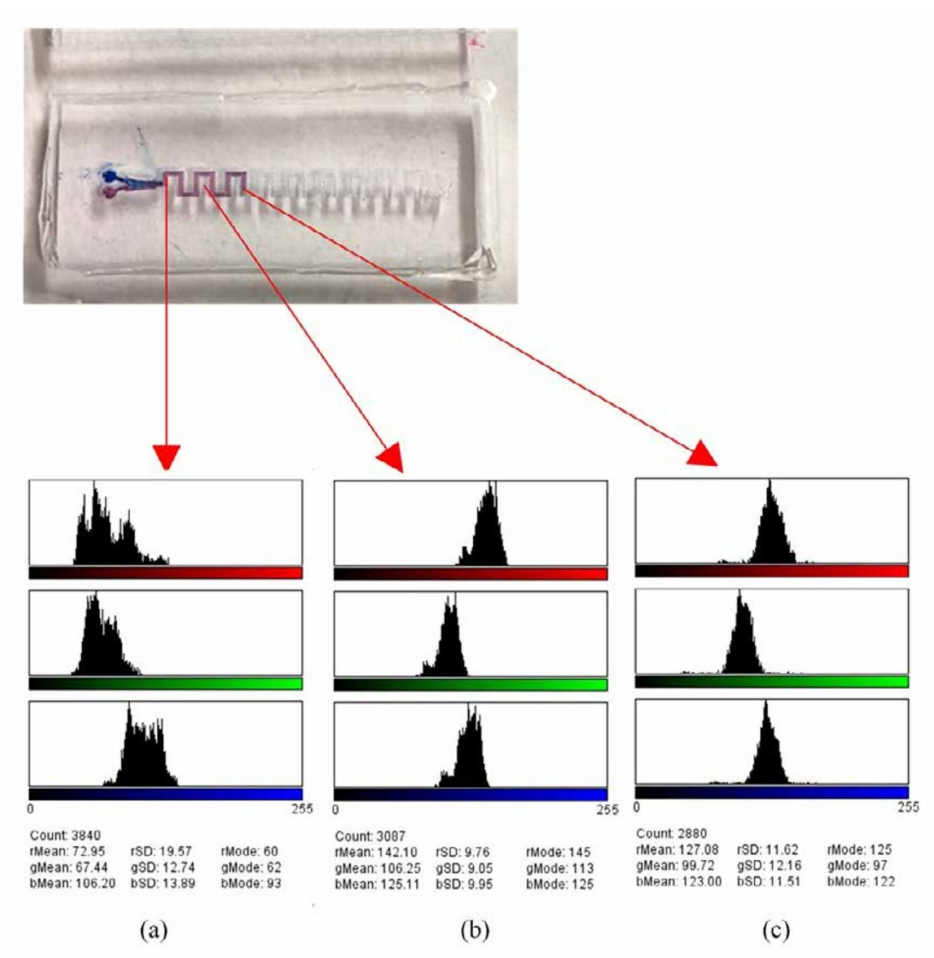
Figure 16. The experiment and analysis of the capillary-driven meander mixer at the: ( a ) Front, ( b ) mid, and ( c ) end of the fluidic flow.